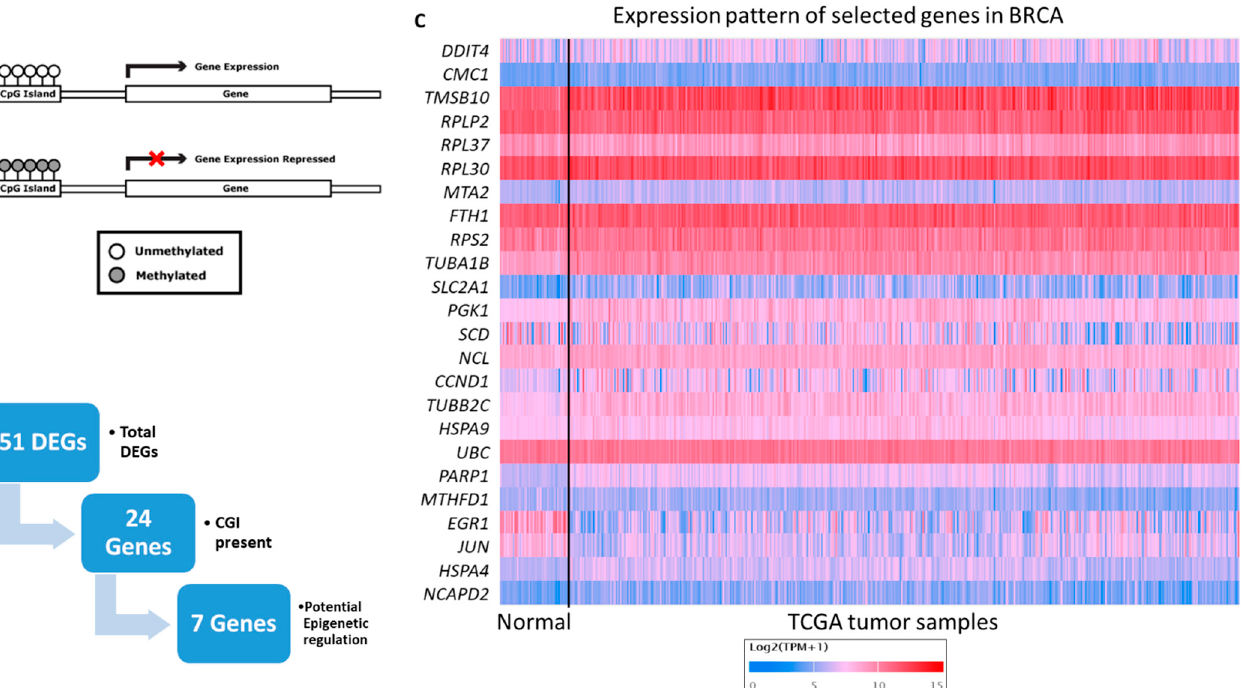
Table 1. Details of the genes highly likely to be epigenetically regulated in crocodile serum treated breast cancer cells.